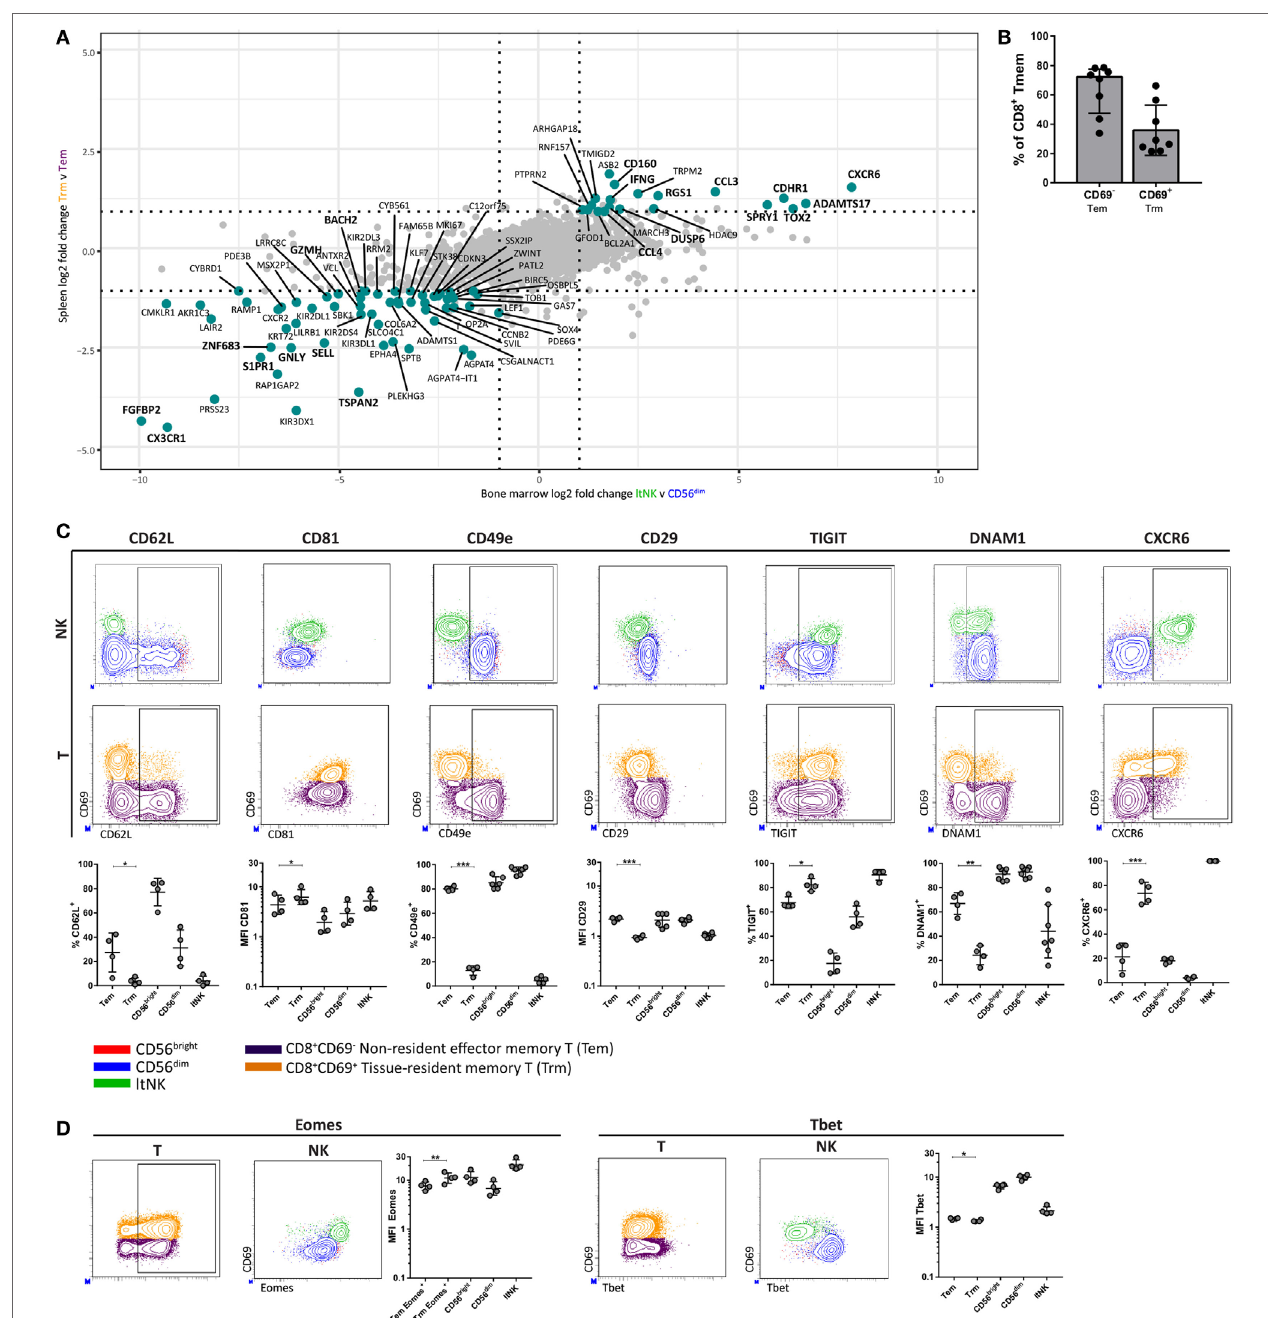
FigUre 7 | LtNK cells and tissue-resident CD8 + memory T cells share a core transcriptional and phenotypic profile. (a) The datasest GSE94964 contains RNAseq data of spleen-derived CD8 + effector memory T cells (CD3 + CD8 + CD45RA − CCR7 − ), which were subdivided into CD69 + tissue-resident memory (Trm) and CD69 − effector memory T (Tem) cells. We compared this gene set to our RNAseq data to determine a core gene signature among Trm and ltNK cells in lymphoid tissues. The log2-fold change (FC) of 8,700 genes [which were both expressed in T and natural killer (NK) cells] was calculated. The log2 FC of ltNK versus CD56 dim was plotted against the log2 FC of CD8 + Trm against Tem cells. Figure S5 in Supplementary Material depicts the plot, which contains the log2 FC of ltNK versus CD56 bright NK cells. Core resident genes, which are depicted in turquoise were identified as genes with a log2 FC ≥ 1 or ≤− 1 in all three comparisons. (B) Frequency of CD69 − non- resident (Tem) and CD69 + resident CD8 + memory T (Trm) cells in bone marrow (BM). CD8 + memory T cells were defined as CD3 + CD8 + CCR7 + and included both effector memory and end-stage effector memory T cells. (c,D) Protein expression of surface molecules and transcription factors, which were differentially expressed by ltNK versus circulating NK cells were determined on CD8 + memory T cells (CD69 + versus CD69 − ). For comparison, plots visualizing the ltNK, CD56 bright , and CD56 dim NK cells are shown. The Eomes MFI on the CD8 + memory T cells was determined only on the Eomes + CD8 + memory T cells, rather than on the whole population (as was done for the NK cells). Statistics of NK cell protein expression comparisons are shown in Figure 3 . Dot plots depict a representative BM donor. MFI, mean fluorescence intensity. * P < 0.05, ** P < 0.01, *** P < 0.001, by two-tailed paired t -test. Median and interquartile range are shown in (B) . Mean ± SD are shown in (c,D)